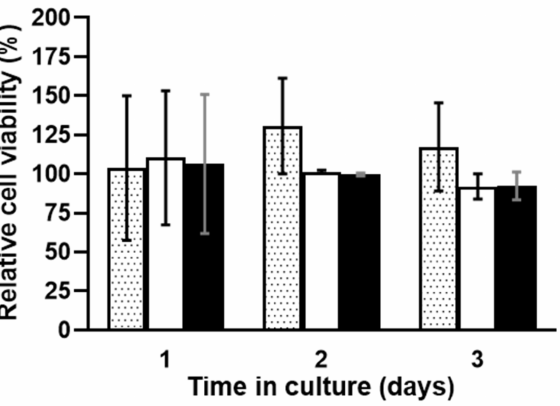
Figure 6. Metabolic activity over time of L929 mice fibroblast cells, control assays (dotted bars) and in the presence of pure chitosan scaffold (white bars) and curdlan–chitosan scaffold (black bars). Cell viability is expressed as % of the control evaluated at d0 (cells cultured in Dulbecco’s Modified Eagle’s Medium (DMEM) with 10% FBS). Values are presented as mean ±